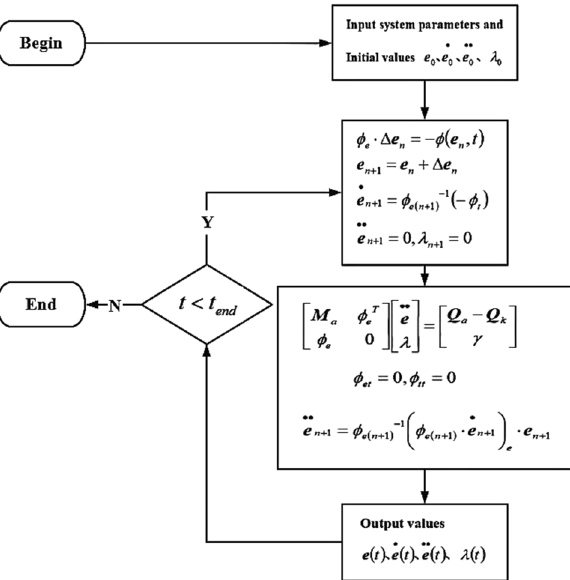
Figure 3. Flow chart of calculation.